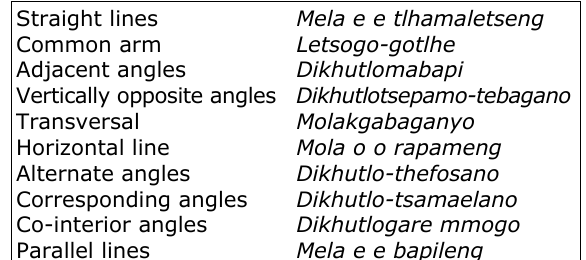
Figure 2: Examples of the terminology in the glossary As the content of the notes consisted of many diagrams and short sentences, it was decided to put the sentences directly below each other, as illustrated in Figure 3.